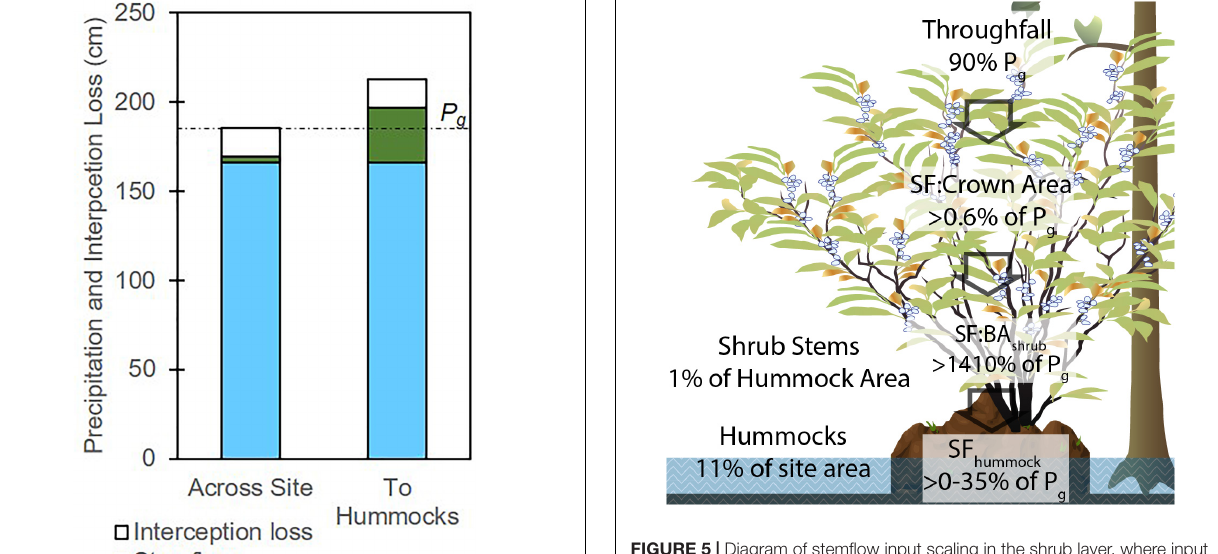
FIGURE 5 | Diagram of stemflow input scaling in the shrub layer, where input is TF from the overstory (90% of gross precipitation, P g ). Across shrub crown areas, 0.6% of P g is routed to stemflow, which equates to over 14.1 times the depth of P g across shrub stem basal areas. Across hummocks, stemflow averaged 17% of P g depths, amounting to hummock net precipitation inputs that were 106% of P g . The plant illustrations are adapted from artwork by Jane Hawkey (Integration and Application Network, University of Maryland Center for Environmental Science;